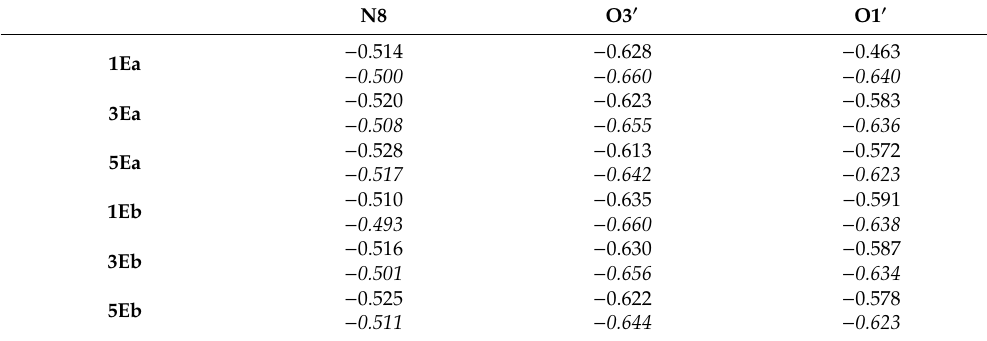
Table 5. NBO charges (M06-2X / def2-TZVP) for selected 2-(aniline-methylidene)cyclohexane-1,3-diones in vacuum (regular font) and solution in DMSO